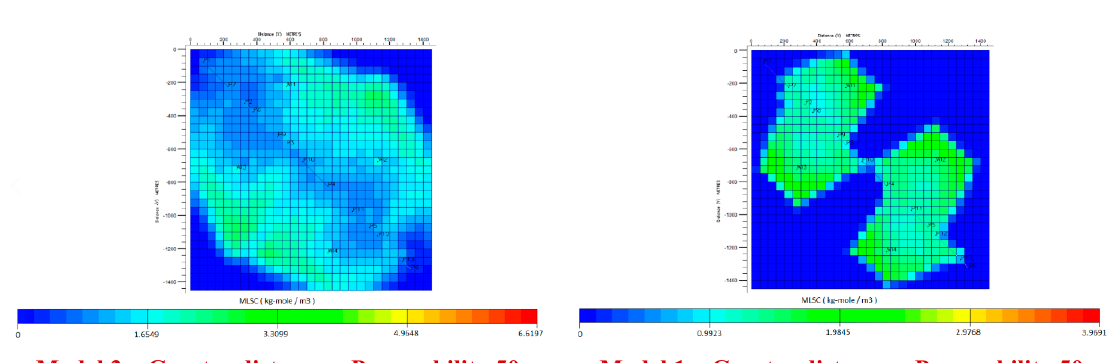
Figure 10. CO 2 molar density change during WAG injection with a WAG ratio of 1:1.